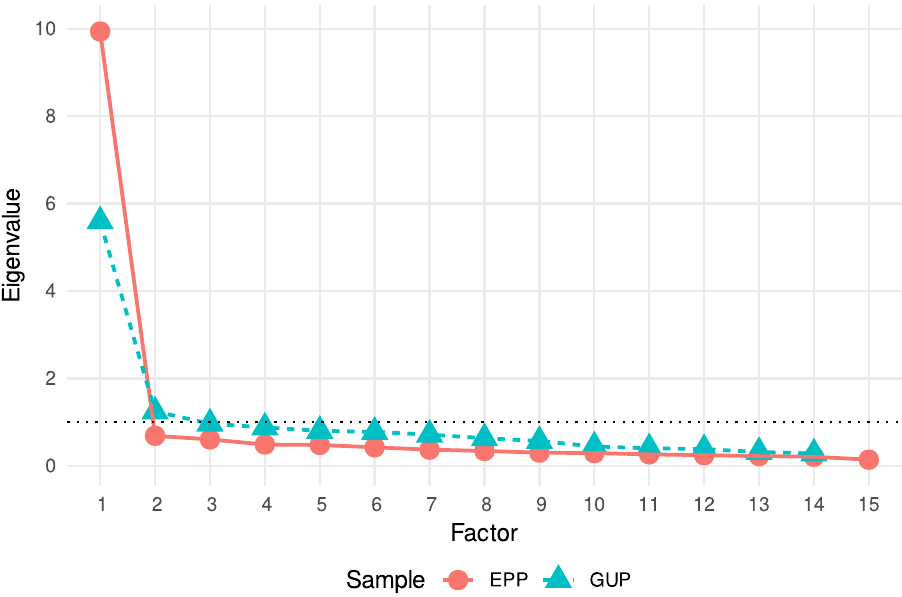
Figure 1. Scree plot for MAAS for EPP and GUP samples. This figure was created using R (v. 4.02) 55 with package ‘ggplot2’ (v. 3.3.5) 56